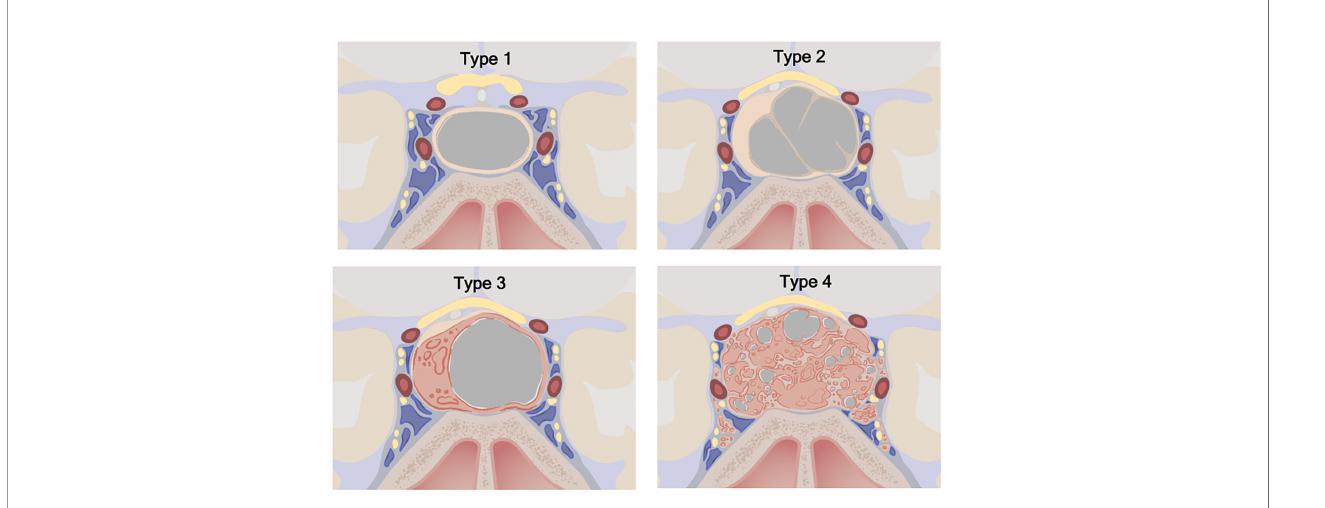
FIGURE 1 | Cystic sellar lesion classi fi cation scheme. Type 1: No solid component; well-circumscribed, homogenous cyst. Type 2: Little or no solid component; irregular cyst, with septations or abnormal walls. Type 3: Obvious solid component; well-circumscribed homogenous cyst. Type 4: Obvious solid component present; irregular cyst(s) with septations or abnormal walls. Type 1: n=68 (33.2%), Type 2: n=72 (35.1%), Type 3: n=10 (4.9%), Type 4: n=55 (26.8%). ©2020 Xian Boles, Used by